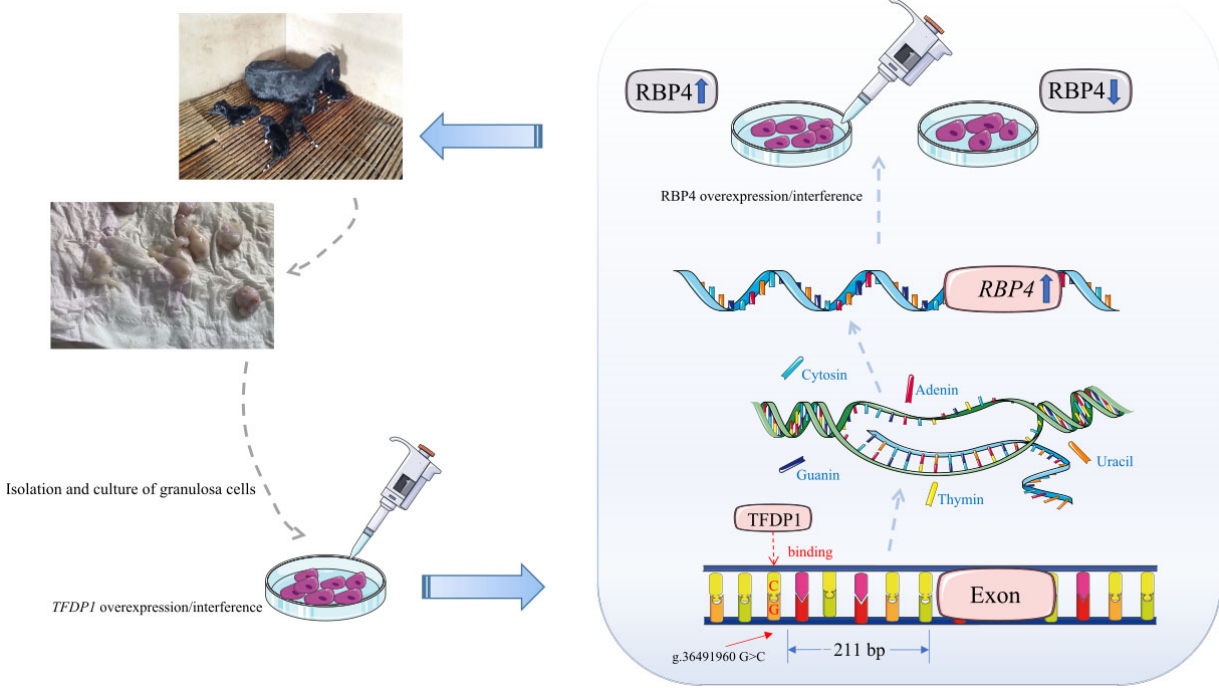
Figure 7. Flow chart of the RBP4 g.36491960G>C mutation regulating the proliferation of goat granulosa cells by the transcription factor TFDP1.